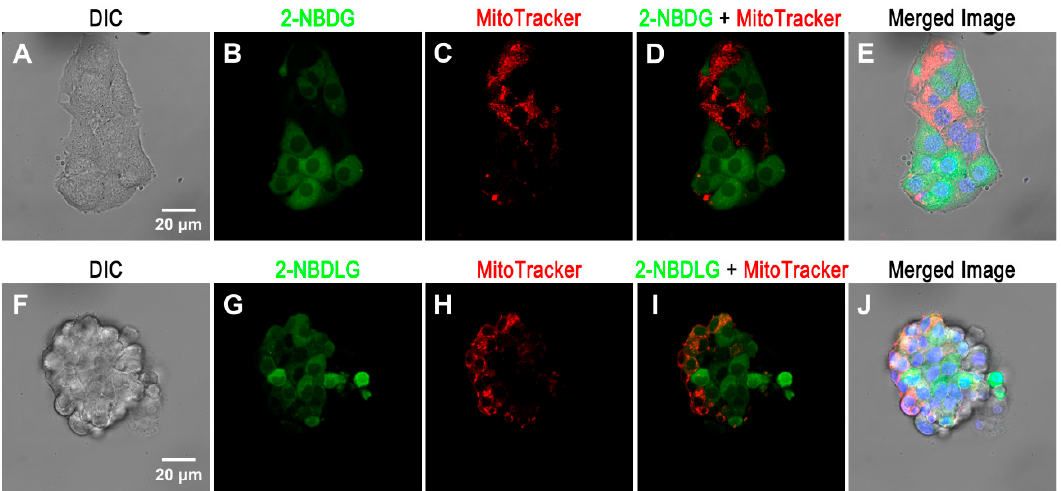
Figure 5. Representative confocal microscopic images of mouse insulinoma MIN6 cell aggregates exposed for a short period to Krebs-Ringer buffer solution containing either 2-NBDG (upper panels) or 2-NBDLG (lower panels). On 7 DIV, uptake of 2-NBDG ( A – E ) or 2-NBDLG ( F – J ) was examined simultaneously with live-staining by 4’,6-diamidino-2-phenylindole (DAPI) (blue, for nuclear staining) and MitoTracker Deep Red FM (red, a mitochondrial membrane potential marker). ( A ) and ( F ) represent di ff erential interference contrast (DIC) images. ( B ) and ( G ) represent fluorescence images of MIN6 cells taking up 2-NBDG (B, green) and 2-NBDLG (G, green), respectively. ( C ) and ( H ) represent MitoTracker images (red). ( D ) and ( I ) represent overlays of ( B ) and ( C ), and those of ( G ) and ( H ), respectively. ( E ) and ( J ) are merged images. ( A – E ) show cells exhibiting a stronger 2-NBDG uptake and lower mitochondrial membrane potential, and vice versa. At this culture stage, some MIN6 cells formed a small spheroid, in which varying 2-NBDLG uptake was detected (Images were taken by Shota Takigawa and Katsuya Yamada, Hirosaki University Graduate School of